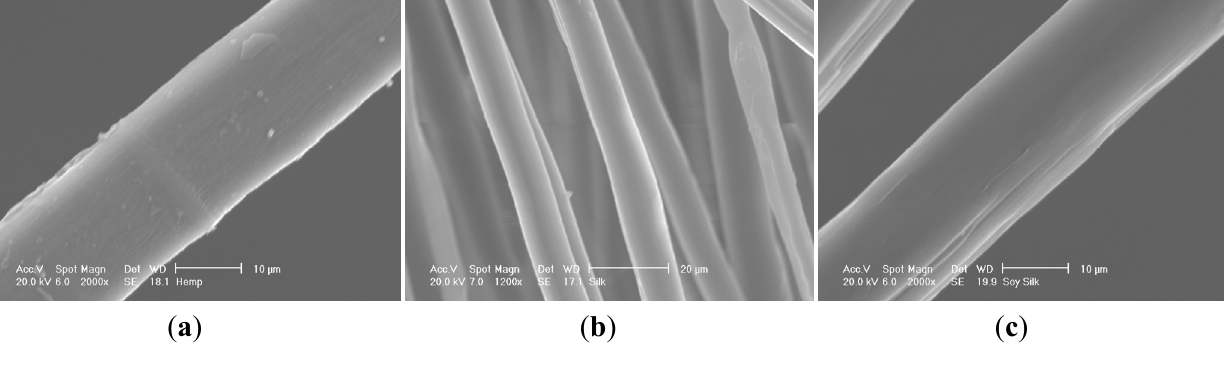
Figure 1. Hemp ( a ), silk ( b ) and soy silk fibers ( c ) used in this study.